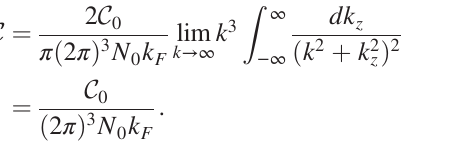
¼ 60 ms with the ramp